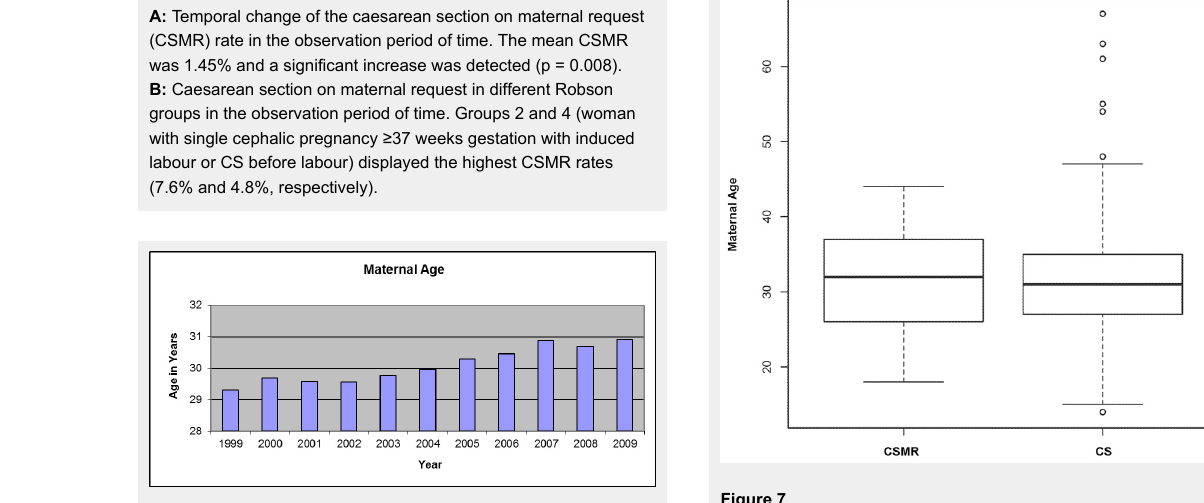
Comparison of maternal age in mothers with caesarean section on maternal request (CSMR) and all mothers with caesarean section (CS) was not significant (p =